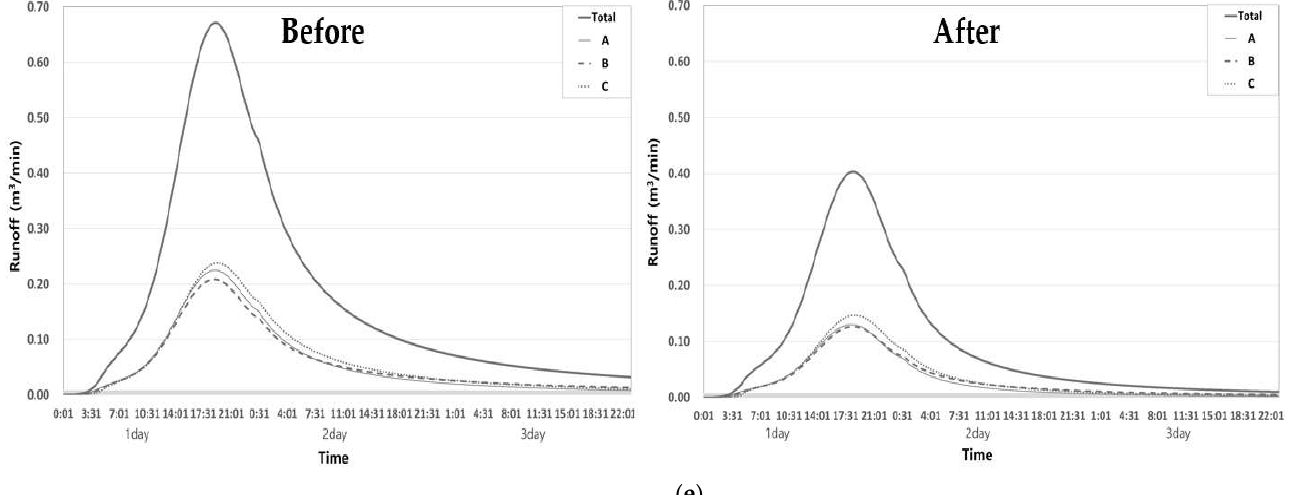
Figure 9. Runoff by return period according to LID facility installation (RCP 8.5, 1988–2100): ( a ) 10- year return period; ( b ) 20-year return period; ( c ) 50-year return period; ( d ) 100-year return period; ( e ) 200-year return period.